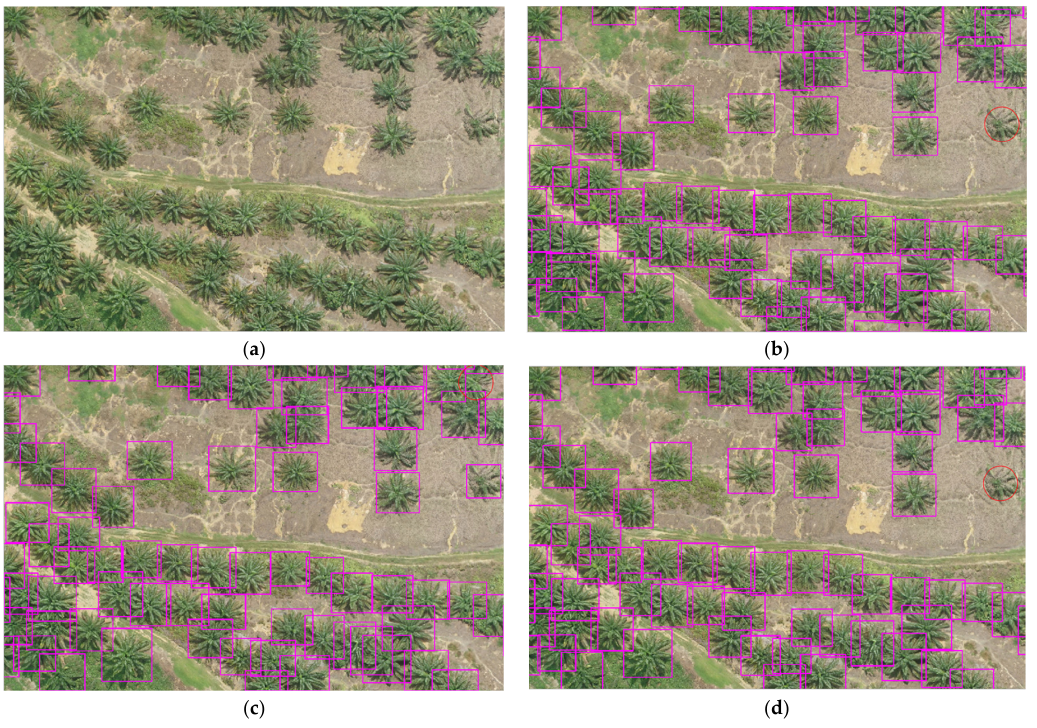
Figure 14. The sparse canopy condition of the oil palm trees: ( a ) Original image; ( b ) YOLOv3 detection; ( c ) YOLOv4 detection; ( d ) YOLOv5m detection.